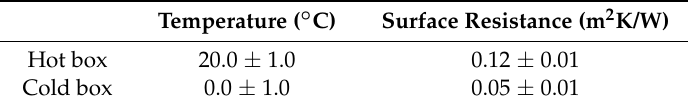
Table 12. Boundary conditions for the U-factor test in accordance with KS F 2278.